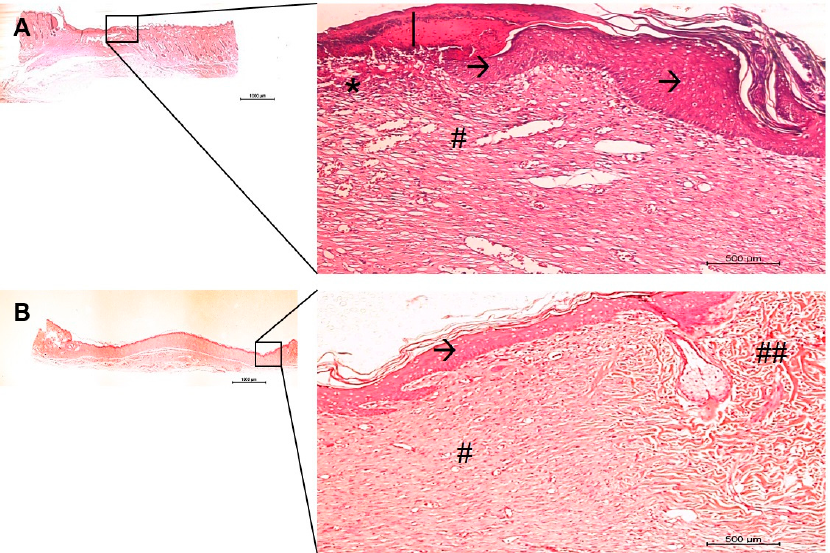
Figure 7. Histological images of the skin wound healing implanted with PVA-AgNP, after 14 ( A ) and 28 ( B ) days. The right images are higher magnification areas from the entire lesion site depicted at left. (*) granulation tissue; (|) fibrin-leucocyte crust; ( A , ￫ ) discontinued hyperplasic early epidermis; ( B , ￫ ) Continuous new epidermis; A dermis fibrous hyperplasia and increased telangiectasia are identified in ( A , #), while lower hyperplasia and decreased telangiectasia are evident in ( B , #), additionally, older areas bordering the wound limits shows normal loose tissue (##). Bars 1000 µm.